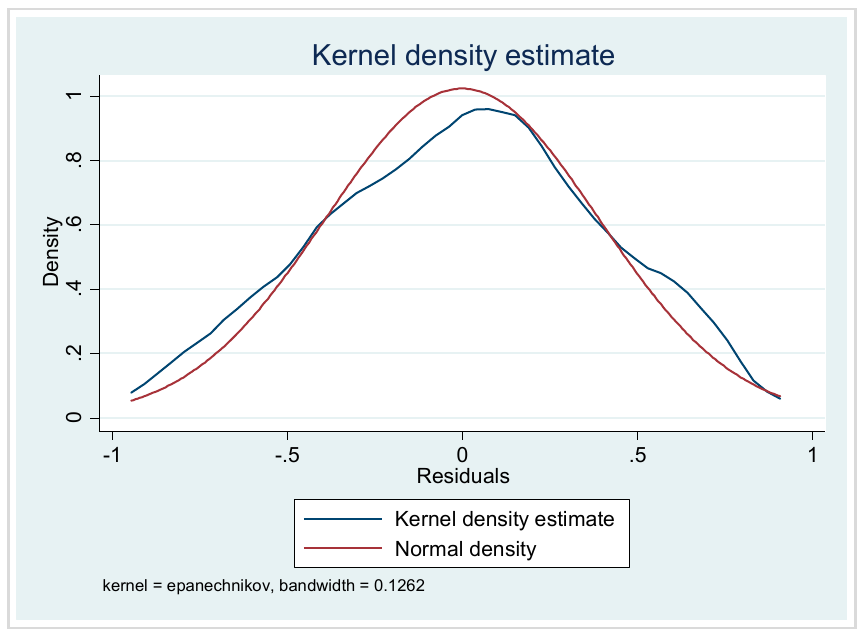
Figure 4. Estimation of the density of normally distributed random numbers.